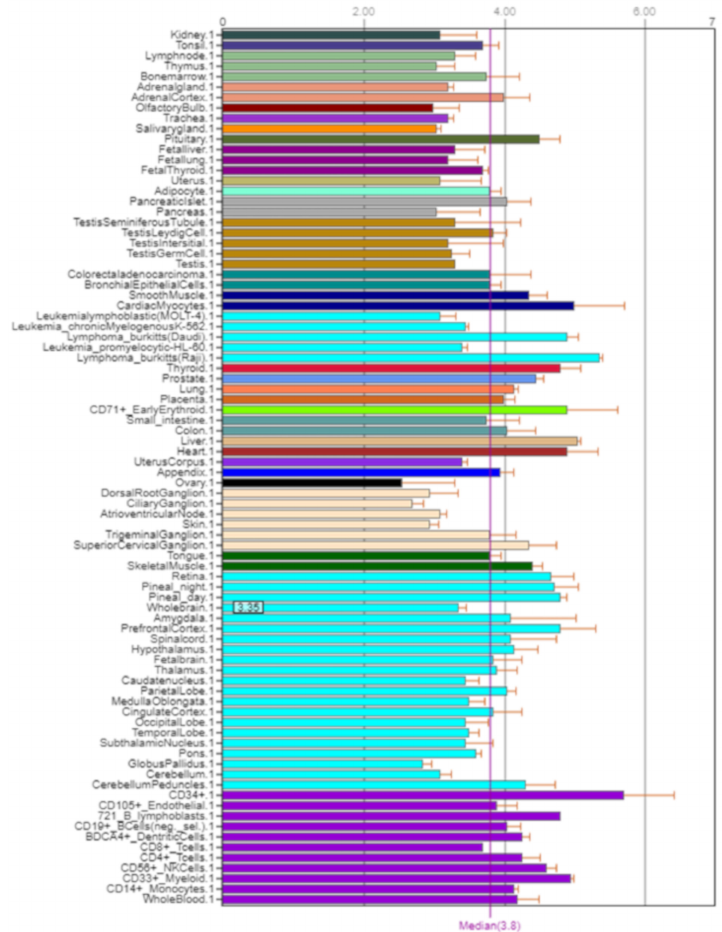
Figure 6. Expression of NOS2 in the human body